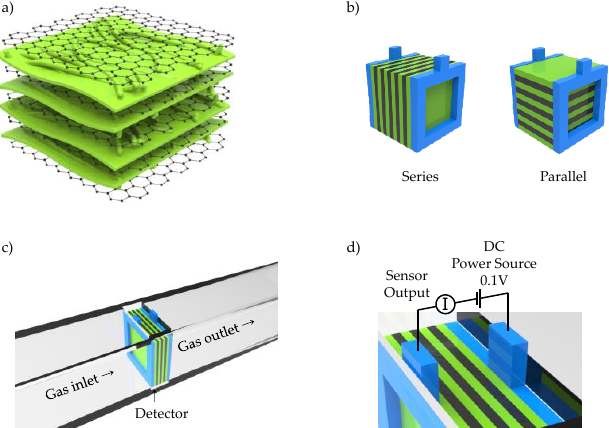
Figure 16. Schematic illustrating ( a ) the alternating layered structure of graphene/PANI; ( b ) the series connection and parallel connection-like structures formed by different orientations of the graphene/PANI film between the electrodes; and ( c , d ) the resistometric sensor setup for measuring the electrical response of the graphene/PANI films (electrode, blue; PANI, green; graphene, black). Reprinted with permission from [153]. Copyright 2016, American Chemical Society.